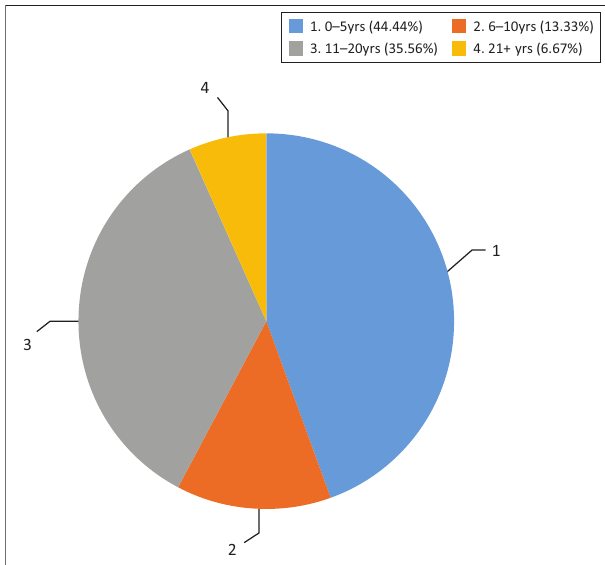
FIGURE 1: Number of years practising as audiologists.